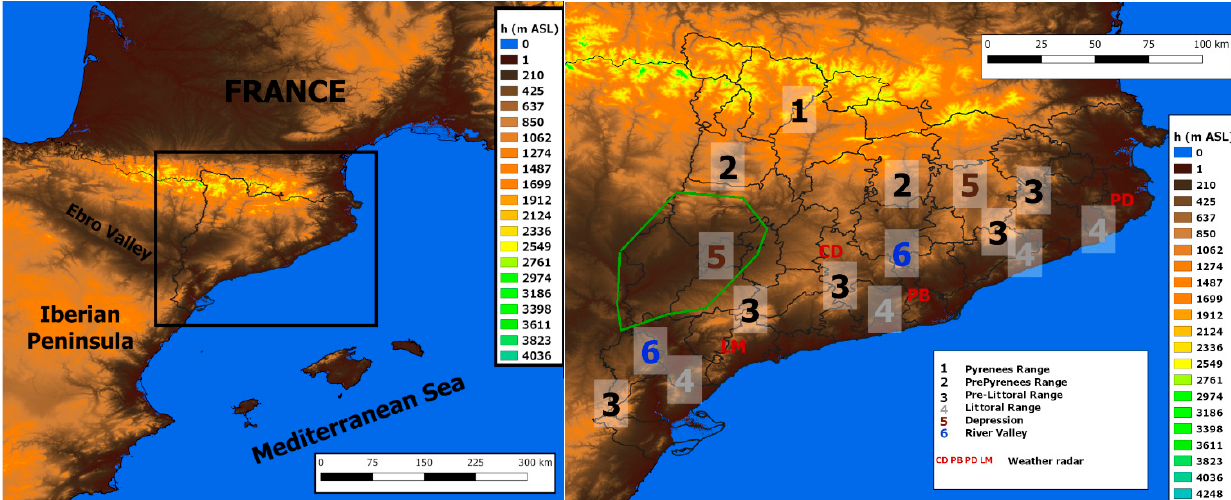
Figure 1. ( Left ): The north-western Mediterranean map with the Region of Study marked with a black rectangle. ( Right ): Main geographic elements in the study region. The red two capital letters indicate the location of the 4 radars of the Servei Meteorològic de Catalunya: CD for CDV, PB for PBE, PD for PDA, and LM for LMI (see the text for more details). The green line polygon delimits the area of hail pads. Topography is presented in m ASL (Above Sea Level).